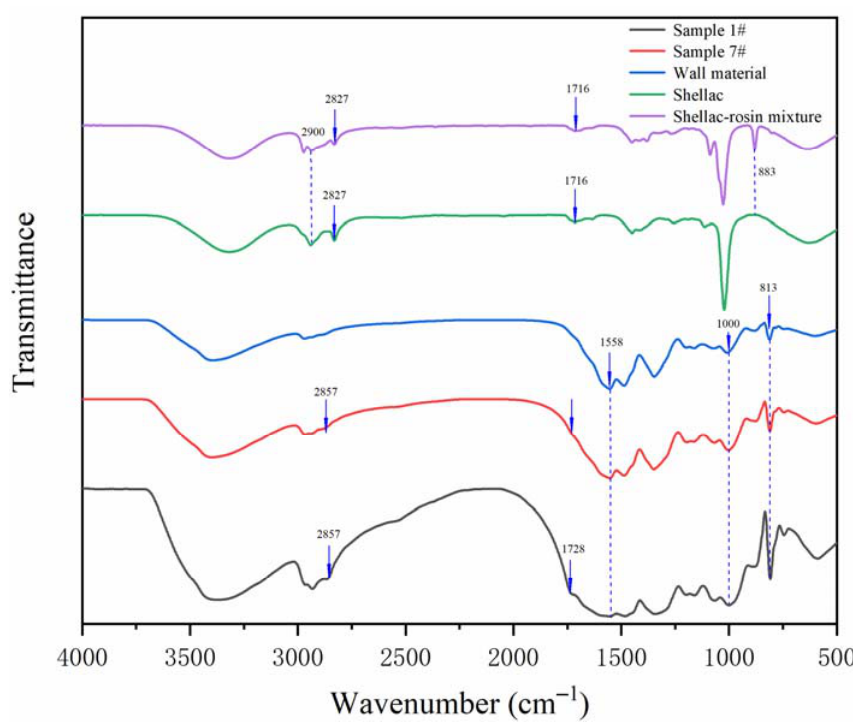
Figure 5. The FTIR of wall material, core material, and microcapsules in the orthogonal experi- ments.